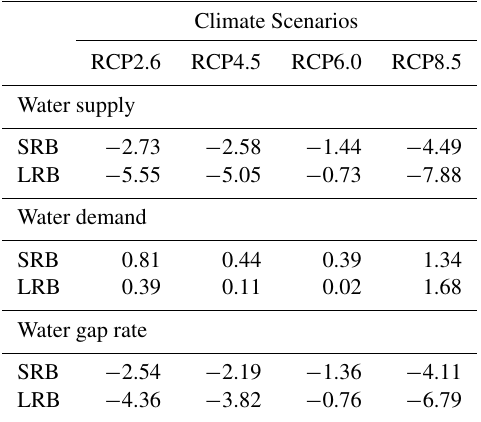
Table 2. Change in the water balance under alternative climate change scenarios compared with the reference scenario in 2030 (%).